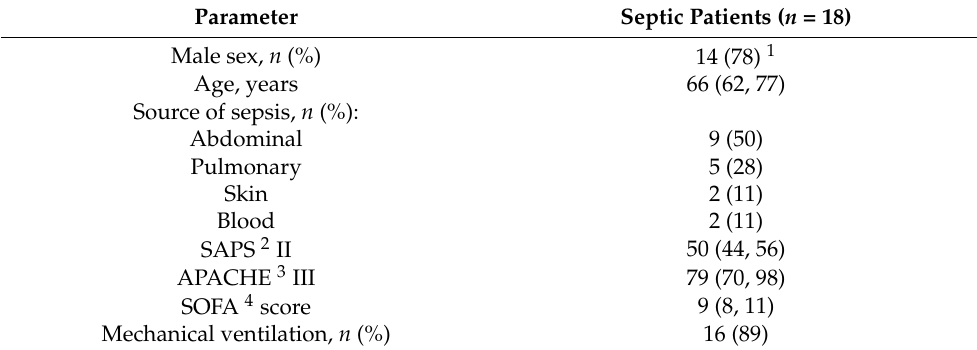
Table 1. Characteristics of the septic